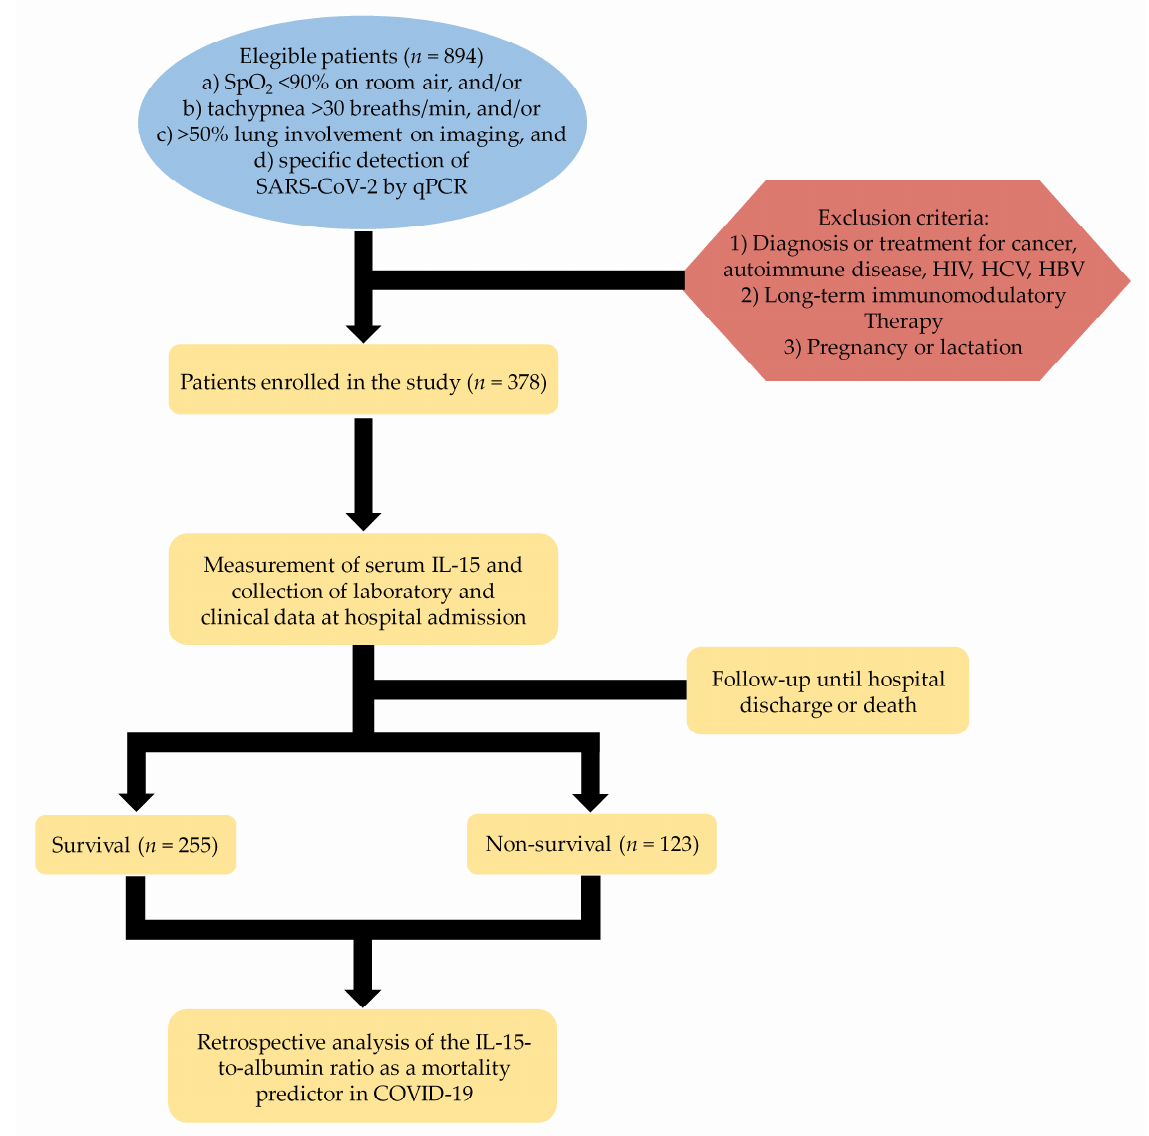
Figure 1. Schematic flow chart illustrating the selection process of eligible patients. SpO2, peripheral oxygen saturation; SARS-CoV-2, severe acute respiratory syndrome coronavirus-2; qPCR, quantitative polymerase chain reaction; HIV, human immunodeficiency virus; HCV, hepatitis C virus; HBV, hepatitis B virus; COVID-19, coronavirus disease 2019.